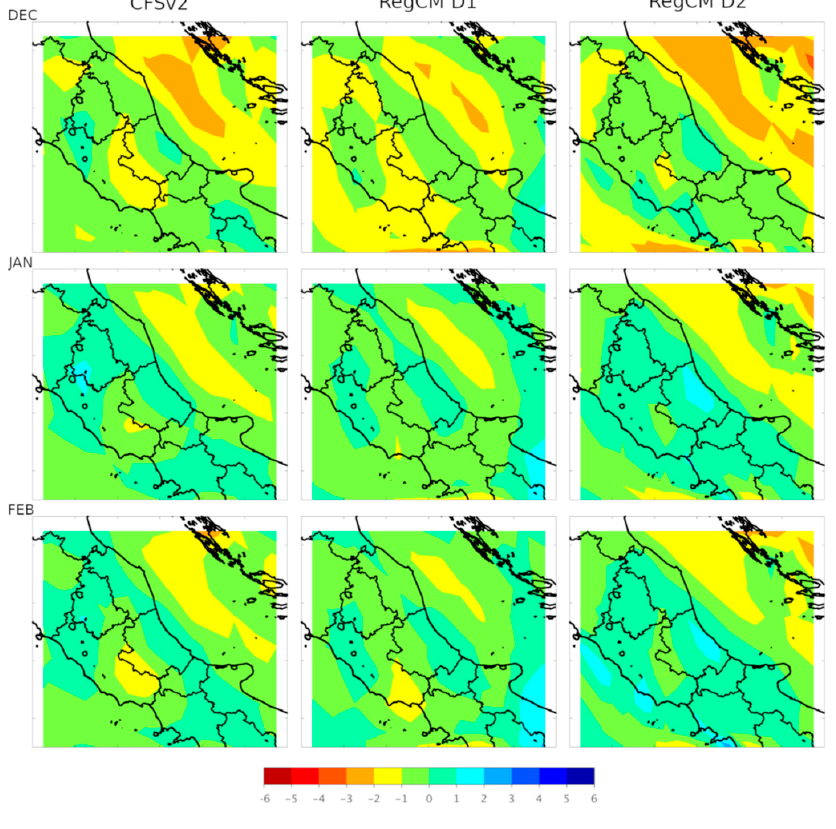
Figure 9. The same as in Figure 2 but for precipitation.